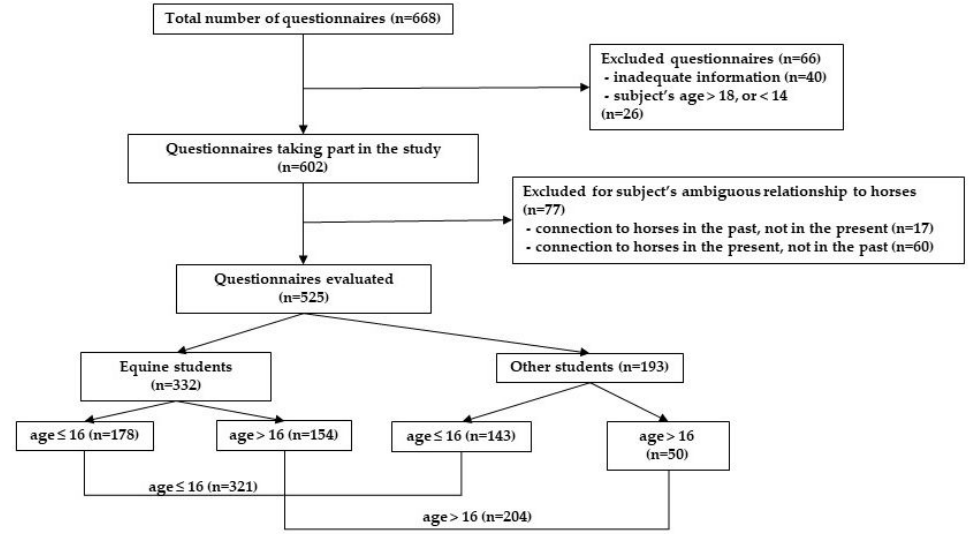
Figure 1. Flowchart showing the participants included in the study.